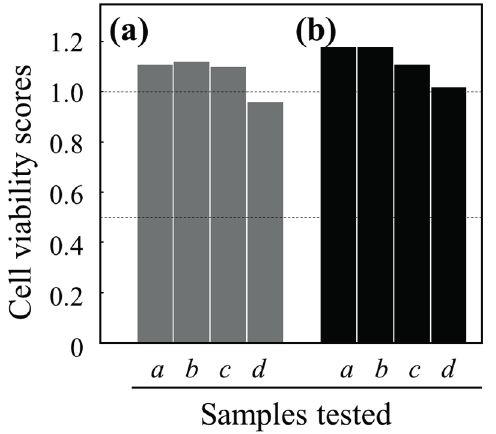
Figure 5. Effect of a PGAIC-based anti-influenza coating agent on the viability (proliferation ability) of Madin–Darby canine kidney (MDCK) cells. ( a ) Non-coated and ( b ) PGA/HDP-coated PET films were subjected to the cytotoxicity tests. Bars a , washings from these film surfaces; b , 10-fold dilution of a ; c , 100-fold dilution of a ; d , 1000-fold dilution of a . PGAIC used as surface-coating materials was thus substantially safe (non-toxic) for human